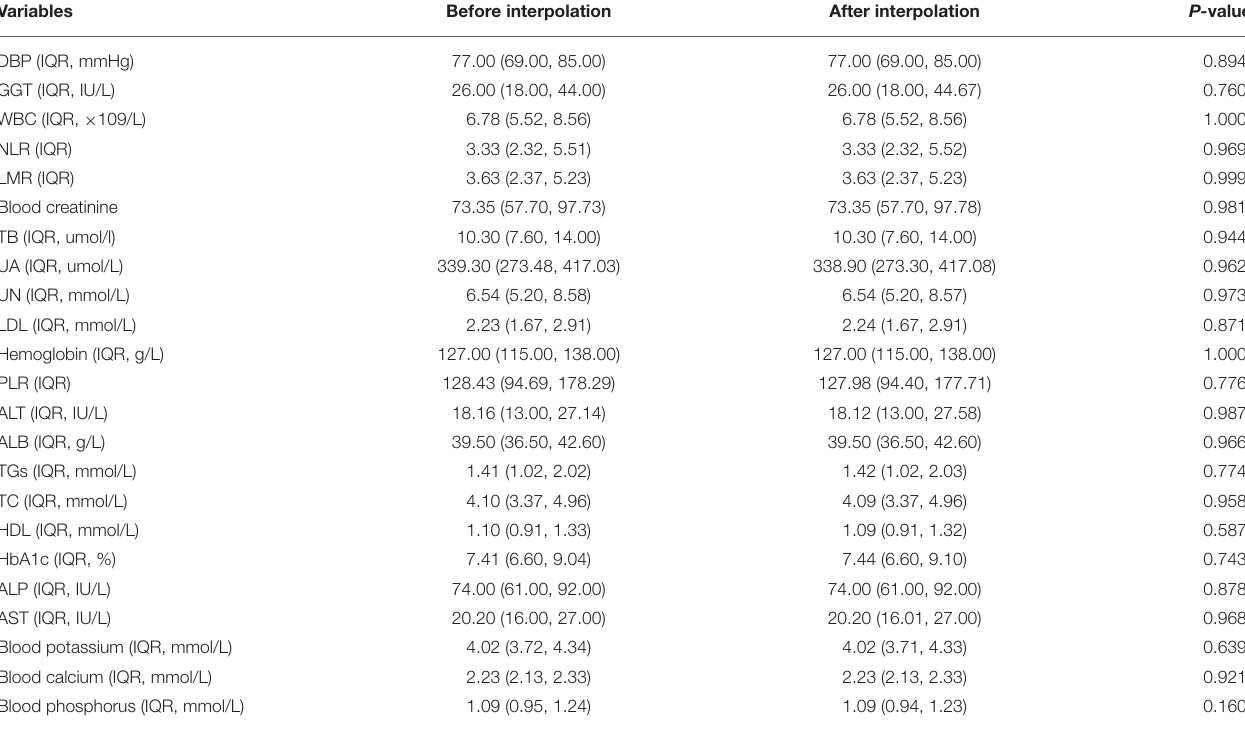
TABLE 1 | Comparison of continuous variables before and after interpolation. Variables Before interpolation After